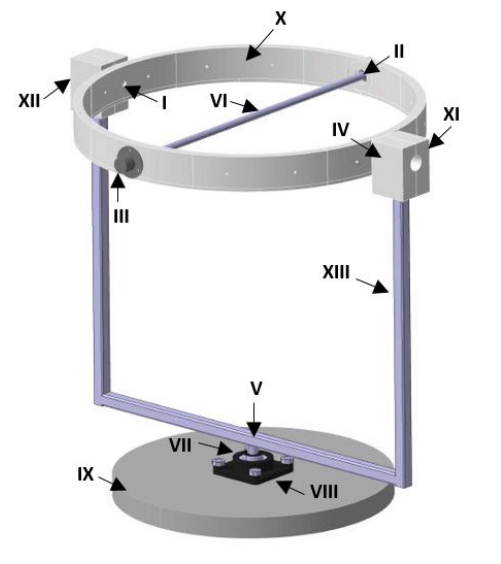
Figure 6. Elements of structural system that constitute gyroscopic